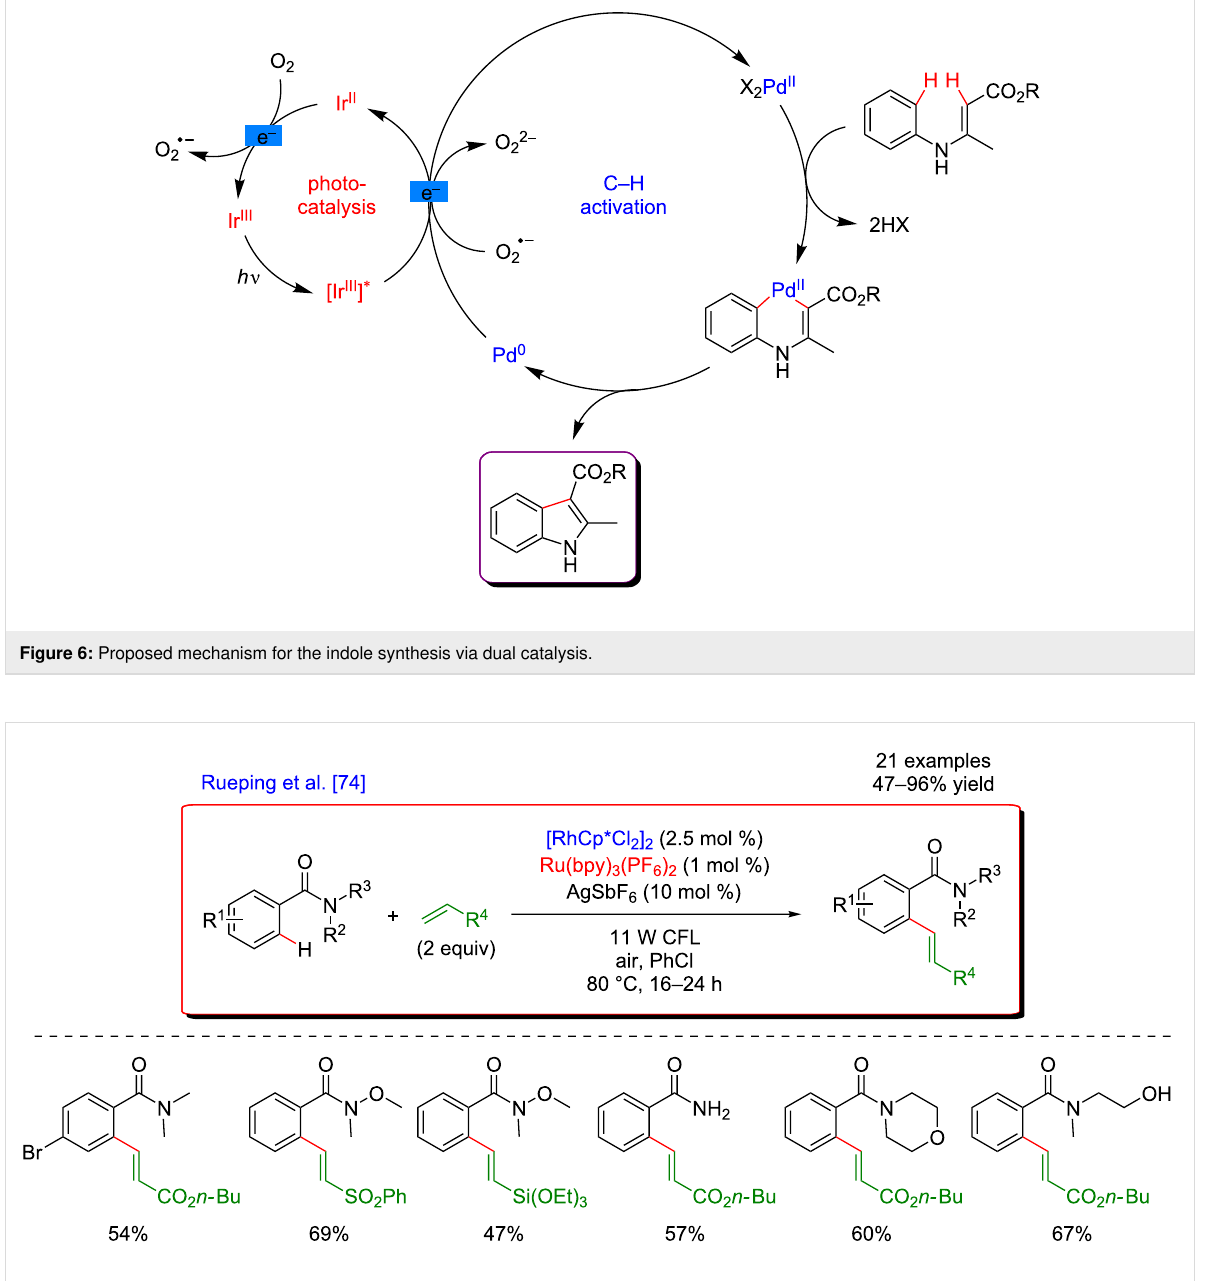
Figure 7: Oxidative Heck reaction on arenes via the dual catalysis.